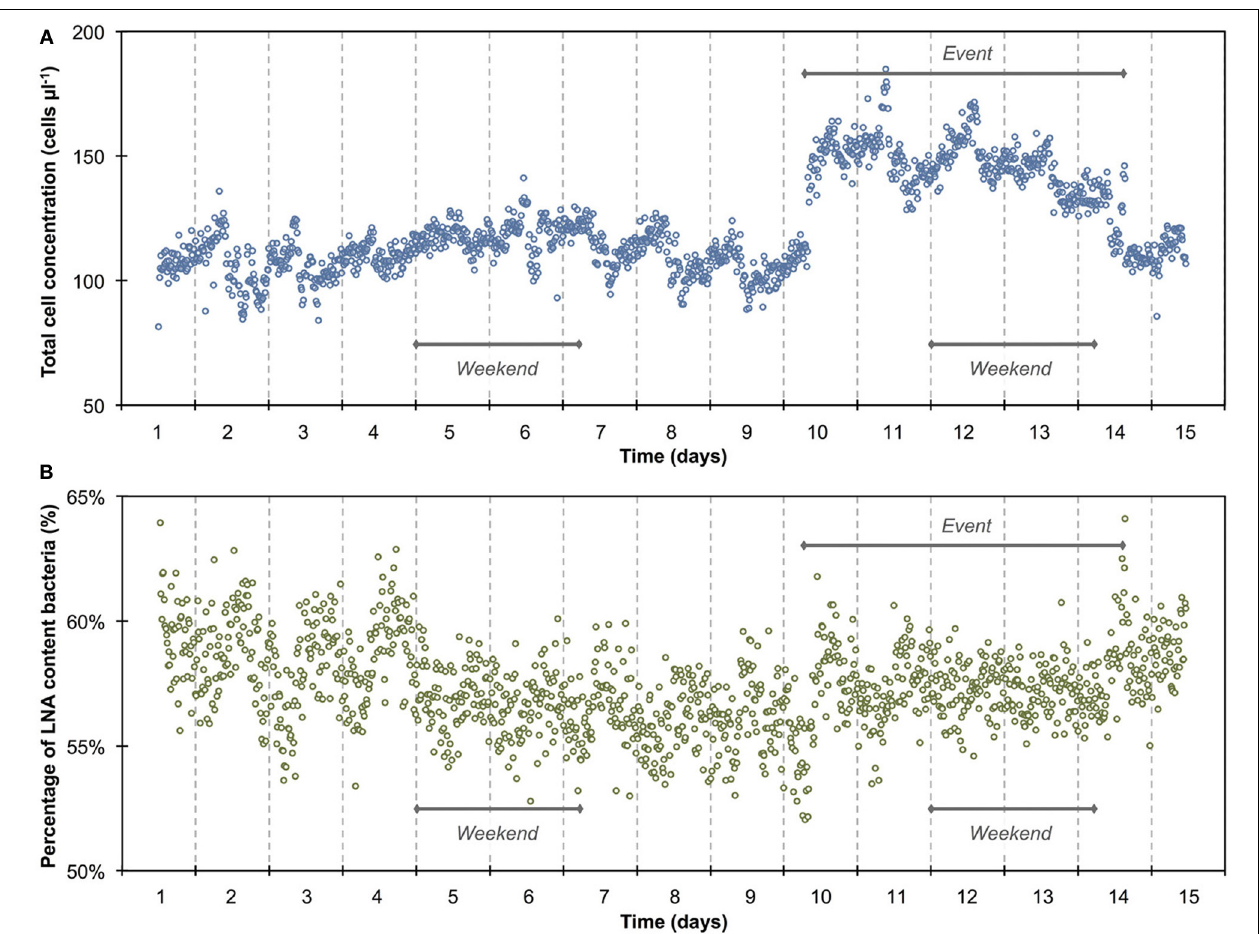
FIGURE 1 | Online FCM measurements of continuously flowing municipal tap water over 14 days, showing the total cell concentration (TCC) (A) and percentage of LNA content bacteria (B) ( n = 1302). Data points are single measurements at 15-min intervals of water samples stained